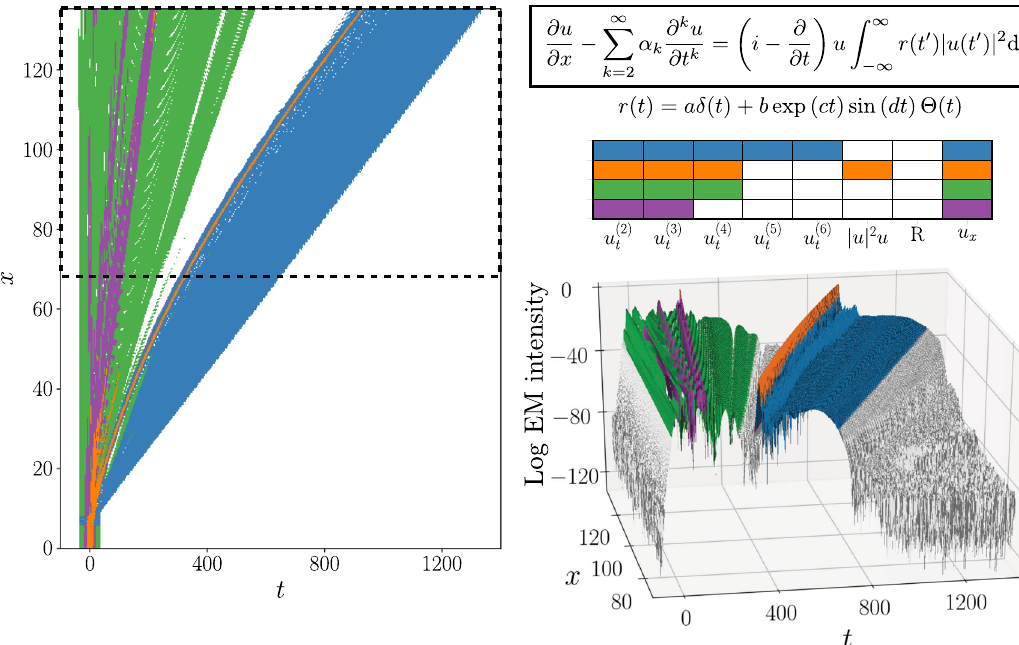
Fig. 3 Nonlinear optical pulse propagation. The governing equations are derived from Maxwell ’ s equations in 1D with a nonlinear time-delayed polarization response. Soliton propagation is understood to be maintained primarily by a balance between low-order dispersion and the cubic Kerr nonlinearity (delta-function component of the right-hand side integral) 31 . Although most of the fi eld is identi fi ed with various linear dispersion relations, the strongest soliton is associated with cubic nonlinearity and dispersive terms through fourth